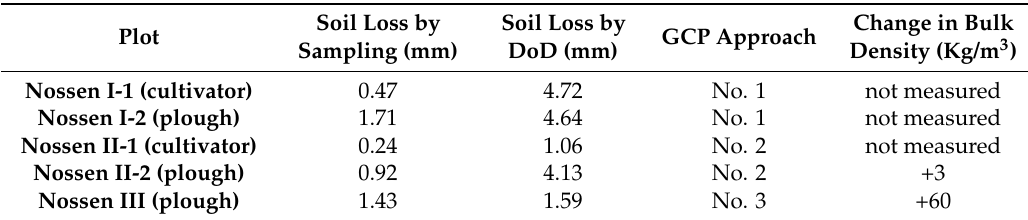
Table 3. The soil loss values per plot and the corresponding ground control point (GCP) approaches and changes in bulk